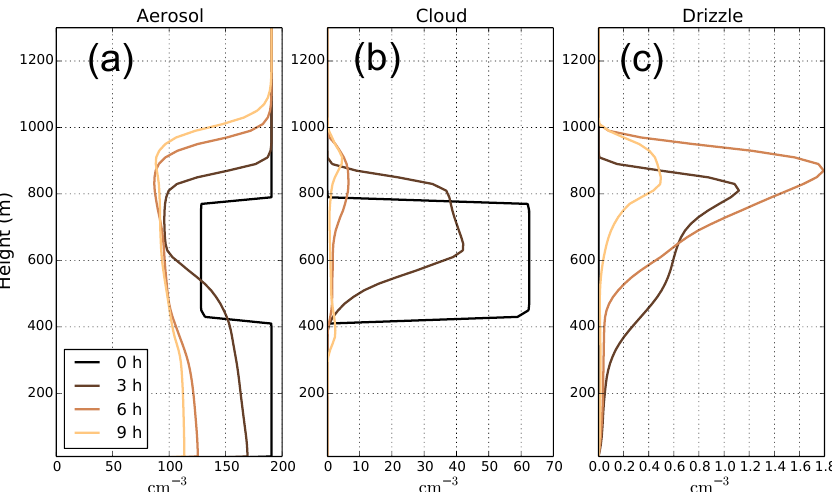
Figure 6. LEV4 domain mean profiles for (a) aerosol, (b) cloud droplet and (c) drizzle number concentrations, plotted in 3h intervals from the initial state of the model to 9h into the simulation (from black to